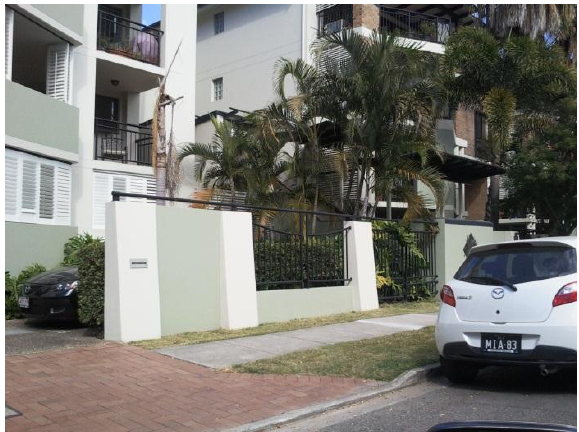
Figure 4. Survey of re-located site image July 2011 A Trimble R8 GPS receiver with TSC2 controller and TDL